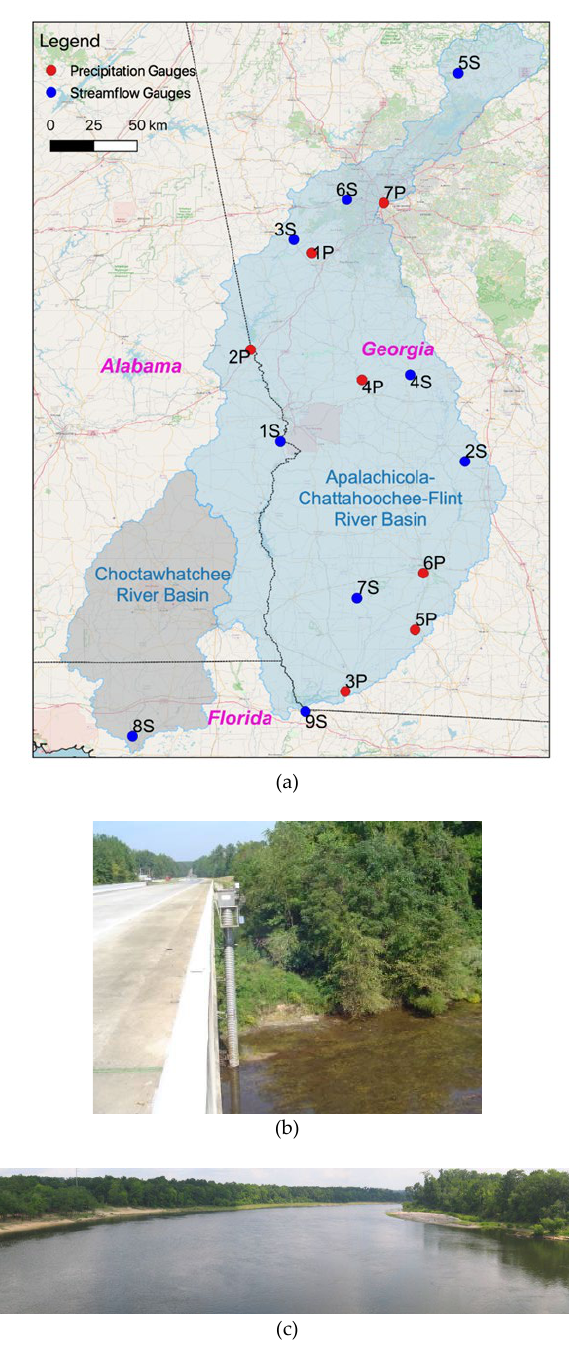
Figure 1. ( a ) Location Map showing ACF and Choctawhatchee basins with streamflow and COOP station locations. The ACF basin is in light blue and the Choctawhatchee basin is in light gray. Stream- flow stations are blue dots: 1S (Uchee Creek), 2S (Turkey Creek), 3S (Snake Creek), 4S (Flint River), 5S (Chestatee River), 6S (Sweetwater Creek), 7S (Ichawaynochaway Creek), 8S (Choctawhatchee River near Bruce, and 9S (Apalachicola River at Chattahoochee, Florida). The NOAA Rainfall COOP stations are identified as red dots: 1P (Newnan GA), 2P (West Point GA), 3P (Bainbridge GA), 4P (Talbotton GA), 5P (Camilla GA), 6P (Albany GA), and 7P (Atlanta GA). Two photographs show surroundings near USGS stations 1S and 8S ( b ) Photo of Uchee Creek near Fort Mitchell, AL (1S) (Im- age source: https://waterdata.usgs.gov/nwis/ accessed on 20 June 2022) ( c ) Photo of Apalachicola River at Chattahoochee, FL (8S) (Image source: https://waterdata.usgs.gov/nwis/ accessed on 20 June